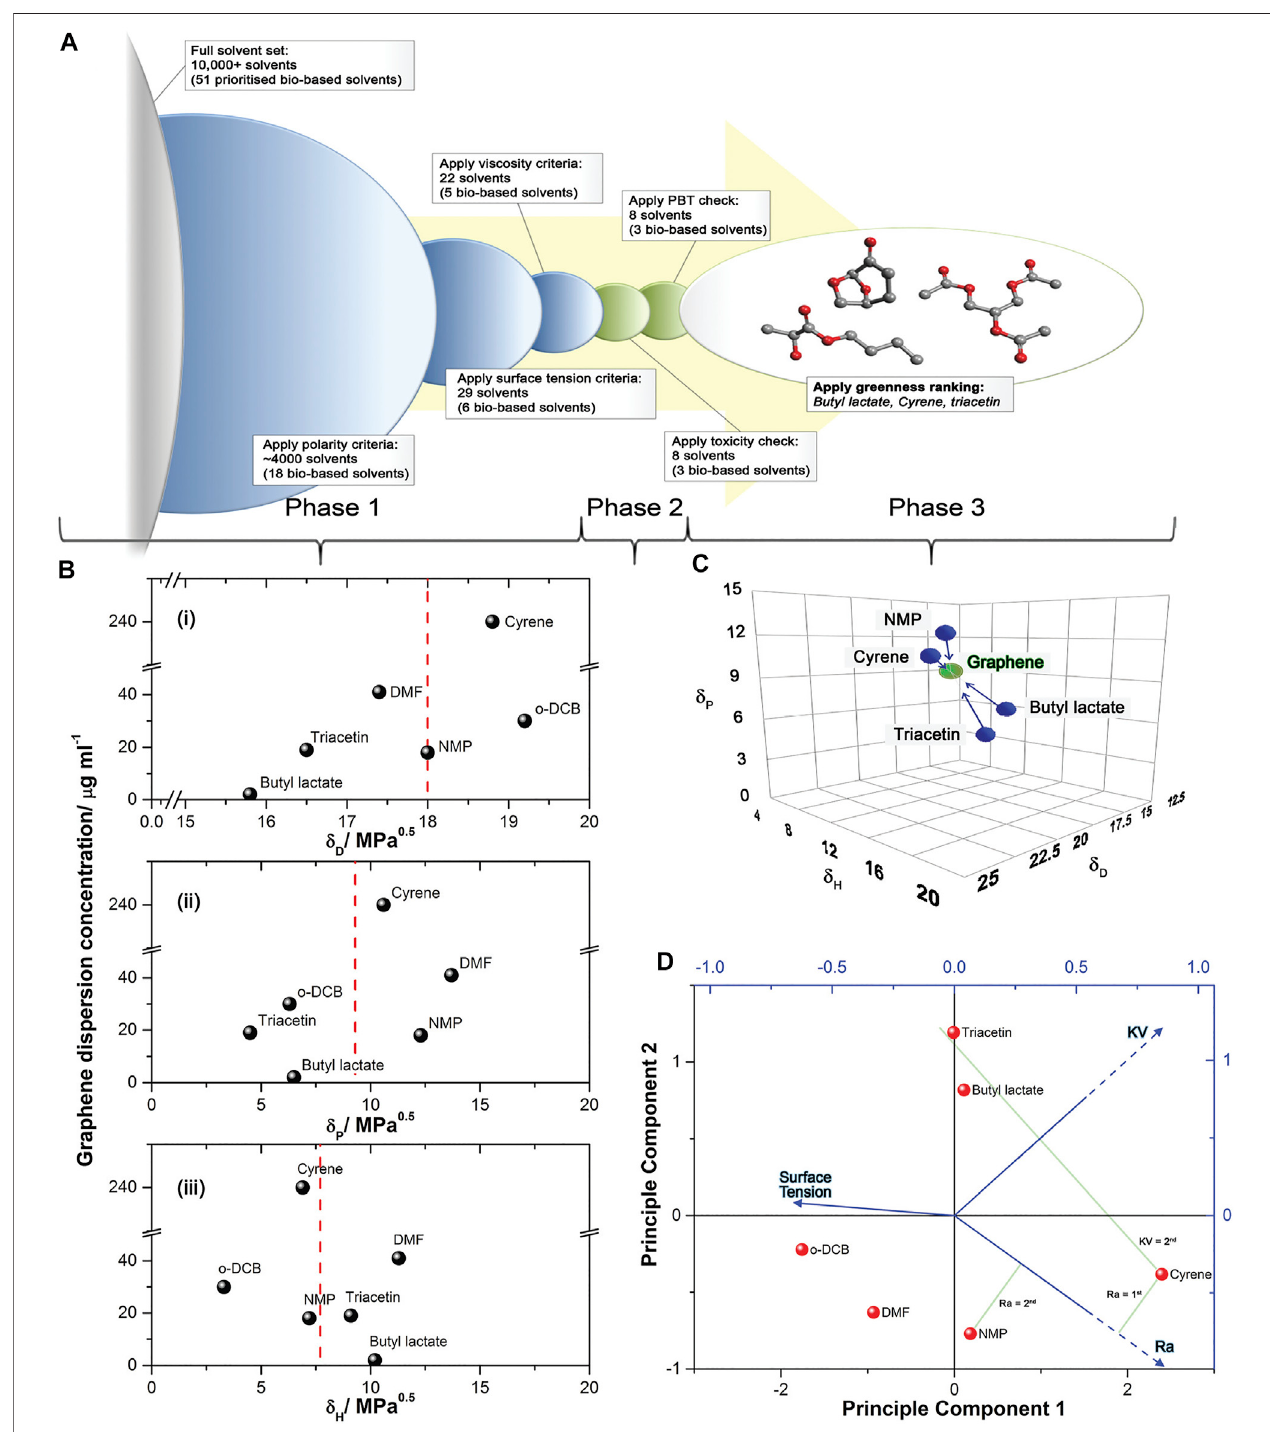
FIGURE 1 | The application of solvent selection criteria for optimizing graphene dispersions. (A) Illustration of the solvent selection steps applied for the computational screening of suitable solvents. (B) Graphene dispersion concentration as a function of (i) dispersive, δ D (ii) polar, δ P and (iii), hydrogen-bonding, δ H Hansen solubility parameters, with the dashed red line being indicative of ideal graphene properties. NMP, DMF and DCB are shown as reference. (C) Hansen solubility map showing the similarity of the fi nal bio-based solvent candidates (and NMP) to graphene in terms of their polarity. The Hansen radius (Ra) is the radius of the sphere in the Hansen space, where each axis corresponds to one solubility parameter. (D) Principle Component Analysis (PCA) bi-plot for candidate solvents (including NMP, DCB and DMF for reference) with vectors indicating surface tension, kinematic viscosity (KV) are and Hansen radius (Ra). Reproduced with permission from Ref (Salavagione et al., 2017). Copyright © The Royal Society of Chemistry 2017.